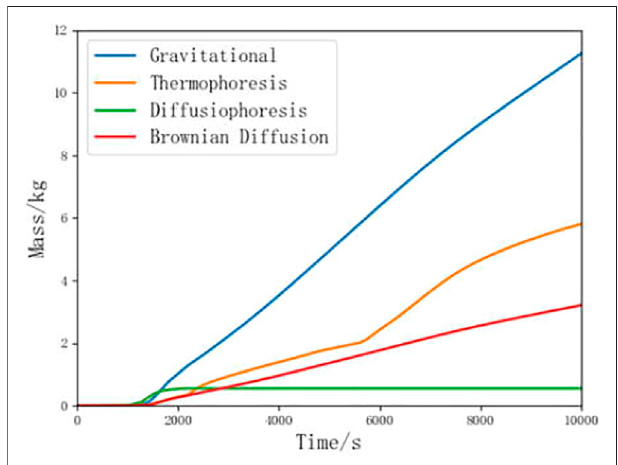
FIGURE 10 | Natural deposition of the CsI aerosol within the containment.